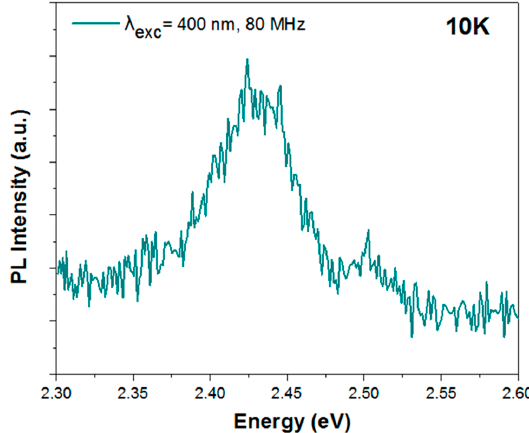
Figure 10. PL spectrum of the millimeter sized MAPI crystal at 10 K, taken six months after its growth under quasi-continuous excitation at 3.1 eV (400 nm) with a 80 MHz doubled-frequency pulsed Ti-Sa laser. Such small PbI 2 traces could not be observed by X-diffraction. These traces couldn’t be either detected from the absorption spectrum. Indeed, from Figures 3 and 4a, the order of magnitude of the MAPI absorption coefficient is evaluated in the 2.4 eV range: 3750 cm − 1 , that is to say that the optical density for a crystal having a thickness of 2 mm will be 750, making impossible to detect weak signals coming from PbI 2 absorption. The low temperature PL is therefore here the only mean to detect these weak PbI 2 traces.